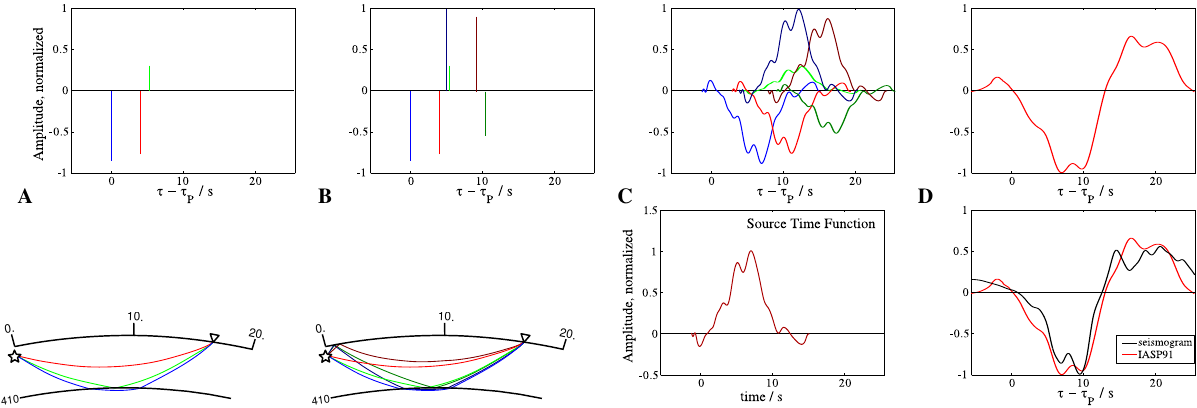
Fig. 3. Schematic composition of a triplicated broadband P-wave signal: (A) Arrival times (top row) and nominal ray paths (bottom row) of the direct P-waves. Three pulses arrive, two of which are refracted above and below the discontinuity (here 410 ), and the third reflected by it. (B) If the earthquake is shallow, additional depth phases arrive (pP and sP), which get triplicated themselves. (C) Real-world seismograms do not resemble sequences of dirac pulses. Rather, the pulses of the Green’s functions are dispersed and the source time function (bottom row) convolves into all of them. (D) The sum of all contributions is the predicted seismogram (top), which may be compared to the observed seismogram (bottom row), in order to extract measurements for waveform tomography. Even though the waveform is complex, it can be modelled sufficiently well using a layered background model.